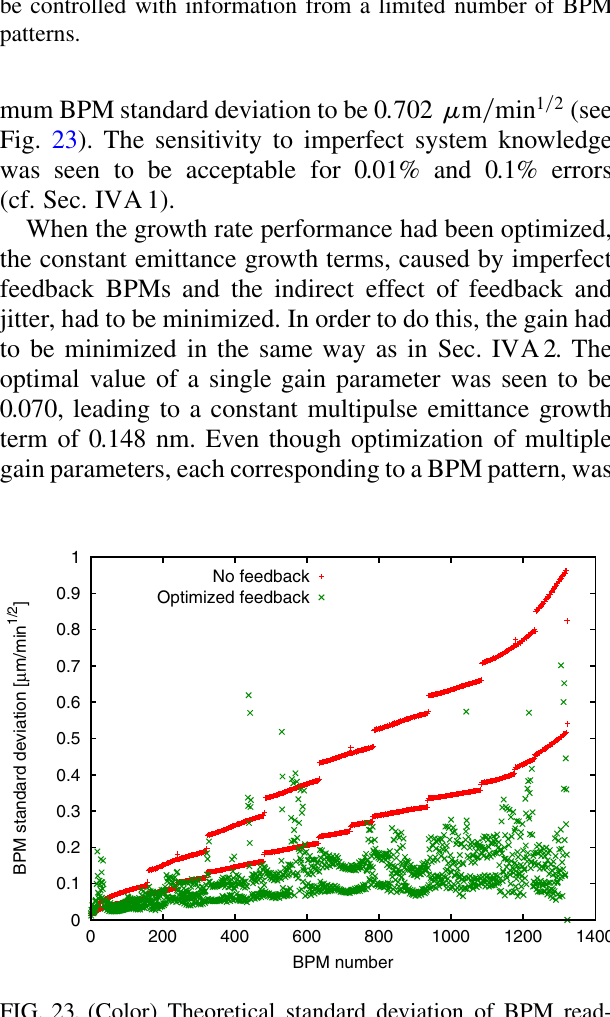
Fig. 23). The sensitivity to imperfect system knowledge was seen to be acceptable for 0.01% and 0.1% errors (cf. Sec. IVA 1).